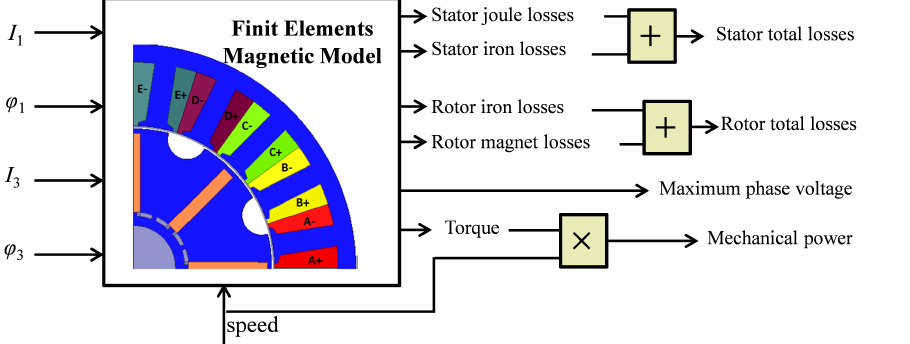
Figure 7. Inputs and outputs of studied global model of the bi-harmonic PM five-phase